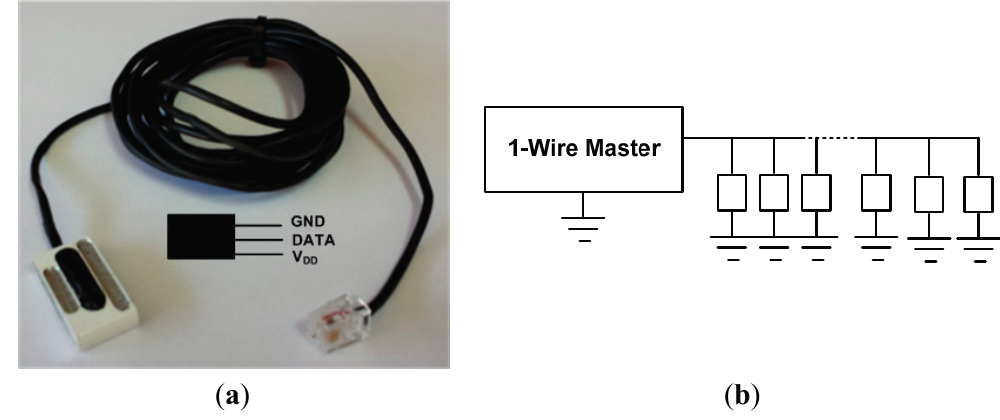
Figure 1. ( a ) Digital sensor for surface temperature measurement. Patent Number: ES 2340013; ( b ) Network topology-level signals.